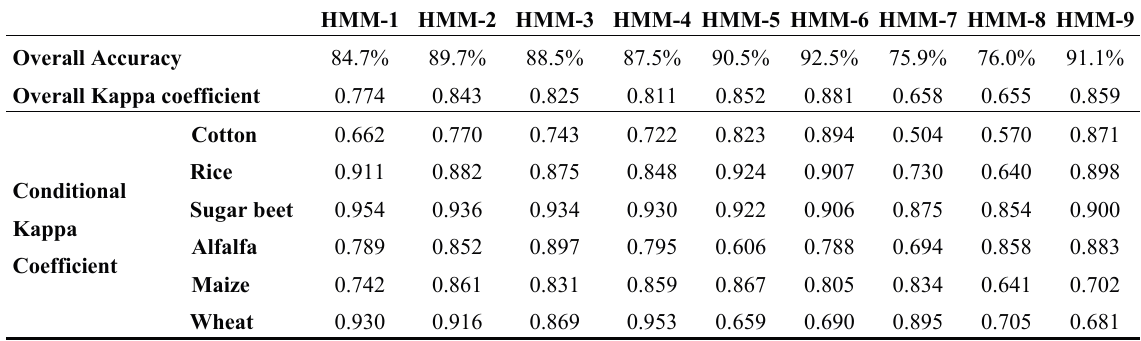
Table 3. Overall accuracy, overall kappa coefficient and the kappa coefficient of each class for all experiments according to the selected